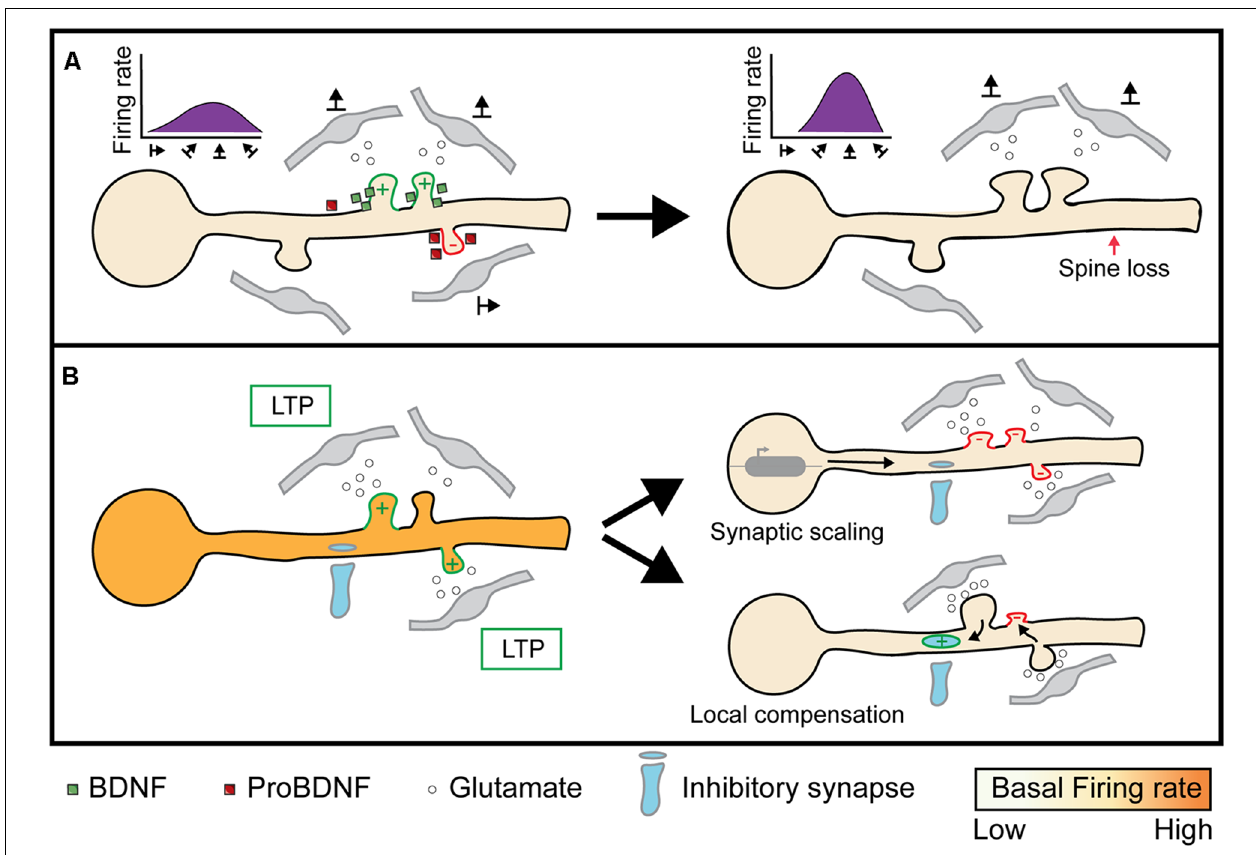
FIGURE 4 | Implications of heterosynaptic plasticity on neuronal activity. (A) Facilitatory or cooperative heterosynaptic mechanisms of plasticity stabilizes the formation of functionally clustered synapses and eliminates out-of-phase synapses through BDNF and proBDNF respectively (left; Niculescu et al., 2018). Convergent activity by functional clusters evokes dendritic spikes, or “hotspots”, through NMDA and Na+ mediated currents, which propagates to the soma and initiates neuronal firing. As a result, functional clusters can narrow the range of somatic firing to specific inputs, such as select orientation preferences (right; Wilson et al., 2016). (B) When neuronal spiking activity is below or above a specific threshold, homeostatic plasticity is triggered to bring the firing rate back to a “baseline” state. Synaptic scaling is one mechanism that scales all synapses multiplicatively to conserve the total synaptic weight (Lambo and Turrigiano, 2013). On the other hand, compensatory homeostatic plasticity acts on neighboring excitatory, as well as inhibitory, synapses to locally conserve synaptic weights (Royer and Paré, 2003; Oh et al., 2015; Field et al., 2020). Image assets reproduced from smart.servier.com (Servier Medical Art, 2015)